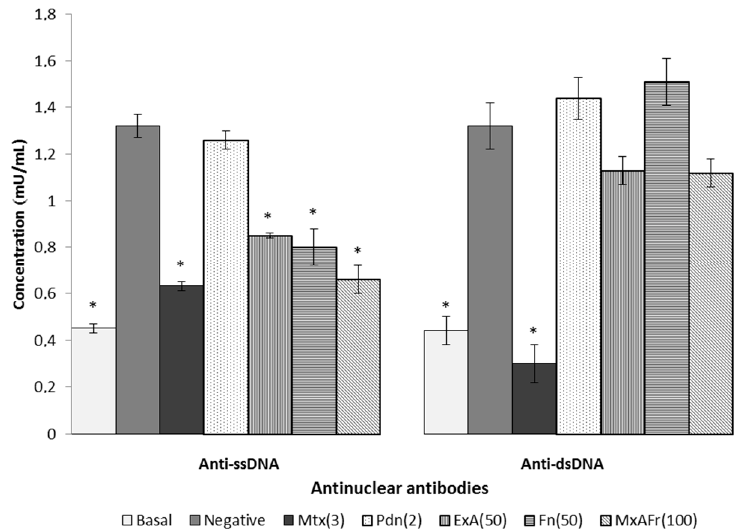
Figure 3. Effect of oral administration of different treatments on the concentration of antinuclear autoantibodies (anti-ssDNA, anti-dsDNA) in serum of Balb/c female mice with SLE induced by pristine administration. Methotrexate, 3 mg/Kg (Mtx); prednisone, 2.5 mg/Kg (Pdn); Agave acetone extract, 50 mg/Kg (ExA); fructans, 50 mg/Kg (Fr); mixture of acetone extract and fructans, 100 mg/Kg (MxAFr) (each column represents an average ± S.E., n = 12, ANOVA, Bonferroni post-test, * p < 0.05 compared to the negative control group).